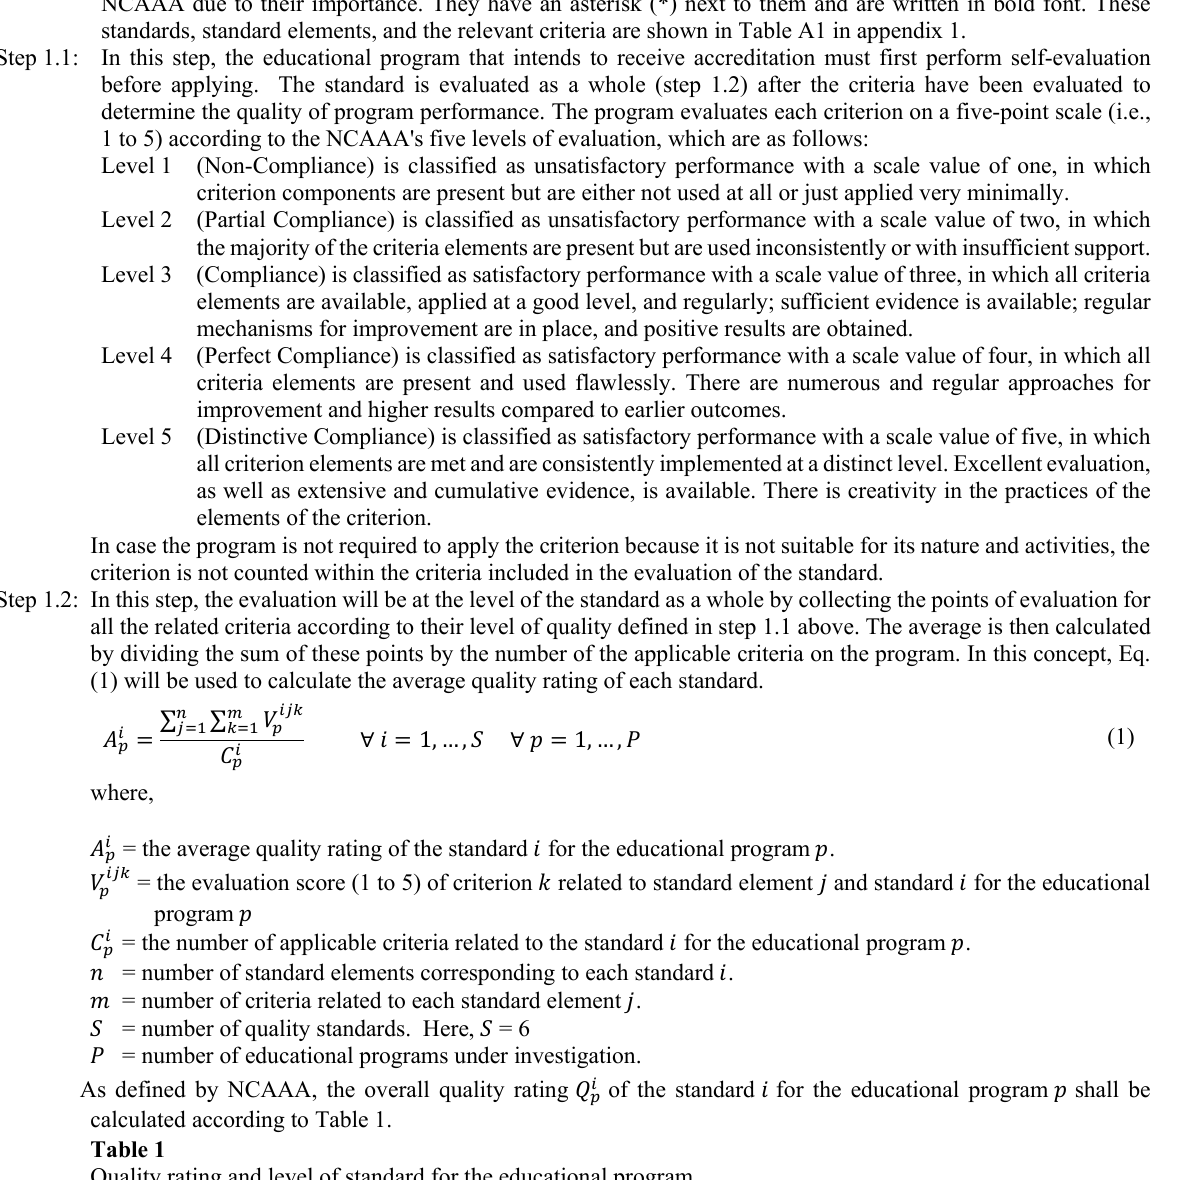
Quality rating and level of standard for the educational program Level of standard Distinctive